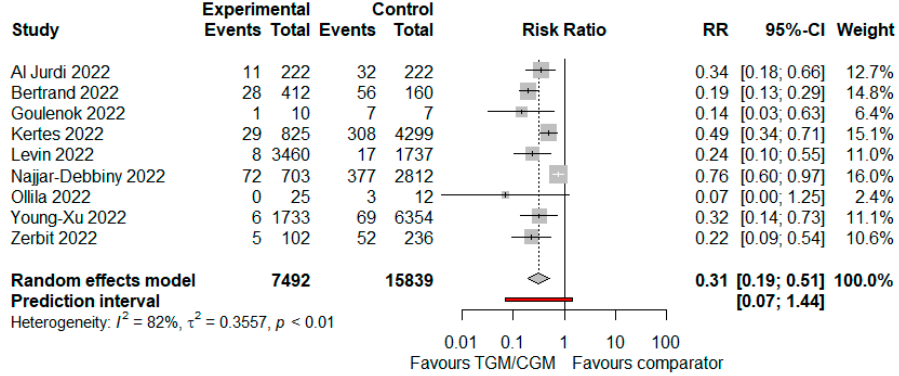
Figure 14. Rate of adverse effects (TGM/CGM vs. comparator). CI, confidence interval; RR, risk ratio; TGM/CGM, tixagevimab/cilgavimab. 4. Discussion This is the largest meta-analysis on the efficacy and safety of TGM/CGM as mAb combination in patients at high risk for breakthrough and severe SARS-CoV-2 infection. This study involving 27,932 participants from 23 cohort, 5 case series, 1 case report, and 1 randomized clinical trial studies found that the majority of the patients treated with TGM/CGM as PrEP against COVID-19 were adults (100%), men (62.8%), and were mainly immunocompromised (66.6%) or high-risk patients for severe COVID-19 (e.g., obesity (BMI ≥ 30), hypertension, smoking, diabetes, or asthma (30.9%)). Our meta-analysis showed that the use of the TGM/CGM-based mAb combination in patients at high risk for breakthrough and severe SARS-CoV-2 infection significantly lowered the RT-PCR SARS- CoV-2 positivity rate and was associated with higher adverse effects ( p < 0.05). The overall rates of COVID-19-related hospitalization, ICU admission, mortality, neutralization of COVID-19 Omicron variant, need for oxygen therapy, and severe and symptomatic COVID-19 were in favor of TGM/CGM regimens compared to an active comparator, pla- cebo, or no intervention for PrEP against COVID-19. The findings of this review should